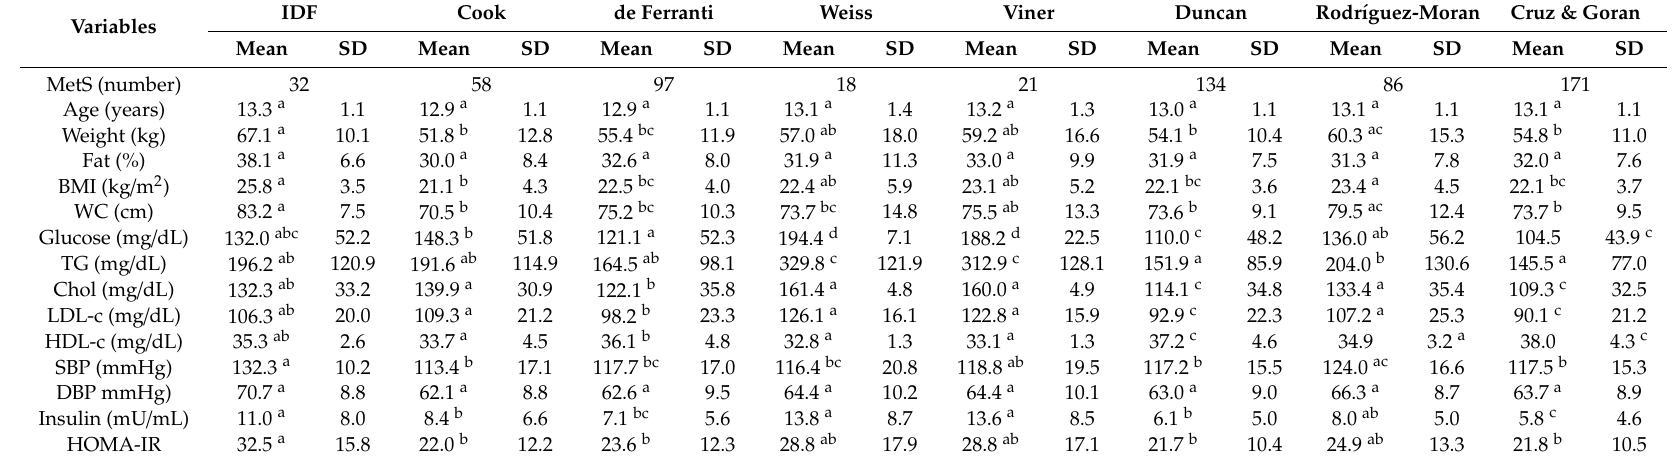
Table 4. Characteristics of girls diagnosed of MetS according to the di ff erent diagnostic